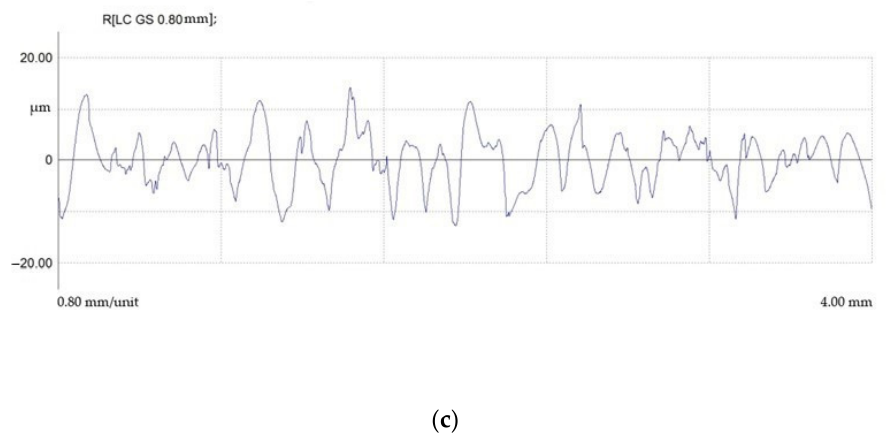
Figure 16. Profilograms of the surface of steel 15 after EDM in finishing mode using ETs from: ( a ) copper; ( b ) graphite; ( c ) composite. Surface profiles after EDM in draft mode are shown in Figure 17.